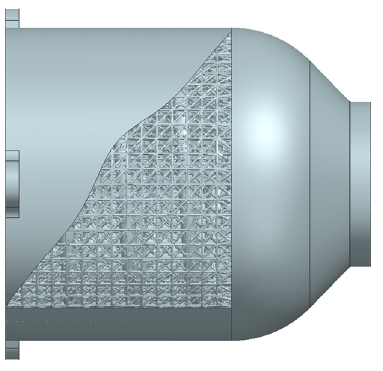
Figure 11. Helical geometry with lattice structures.